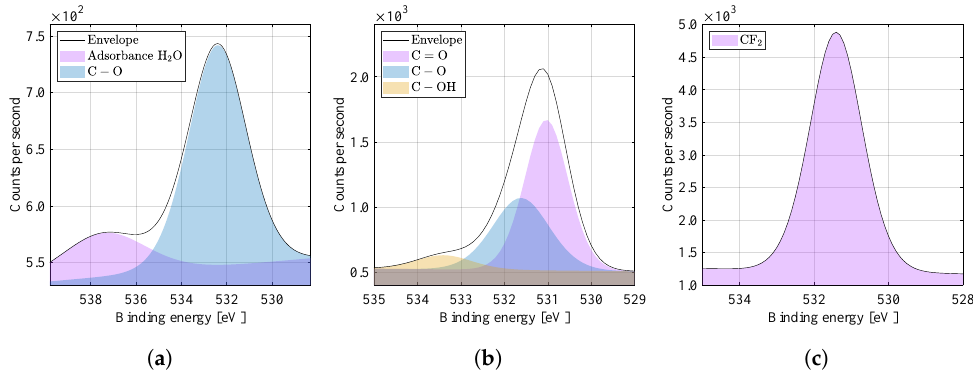
Figure 9. High energy resolution XPS spectra of O1s region. Nanofibers from the ( a ) PVDF, ( b ) PVDF/PA, ( c ) PA6 and their specific binding energies are